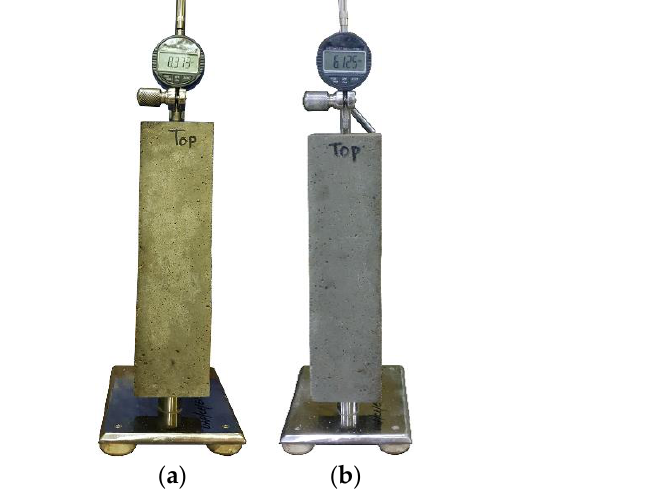
Figure 3. Measurement of concrete expansion made with 100% BA (a) and 100% SSA (b).